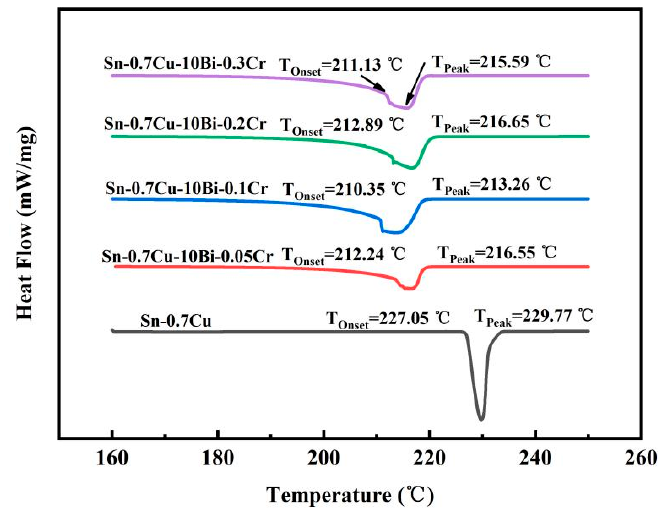
Figure 1. The DSC curves of Sn-0.7Cu-10Bi-xCr (x = 0.05, 0.1, 0.2 and 0.3 Figure 1 . The DSC curves of Sn-0.7Cu-10Bi-xCr (x = 0.05, 0.1, 0.2 and 0.3 wt.%).